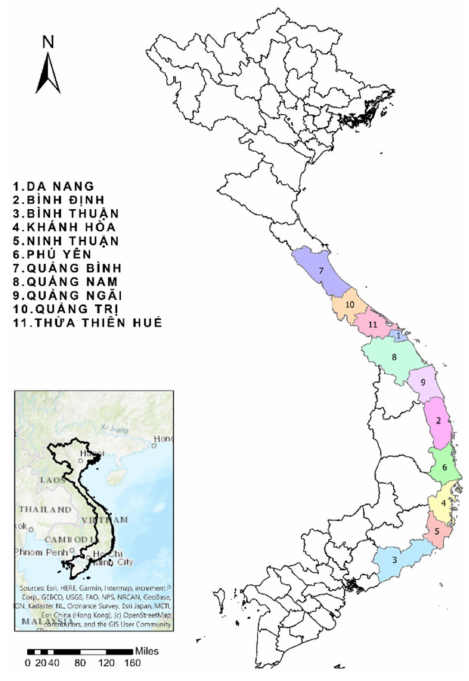
Figure 1. The eleven provinces in central Vietnam included in this